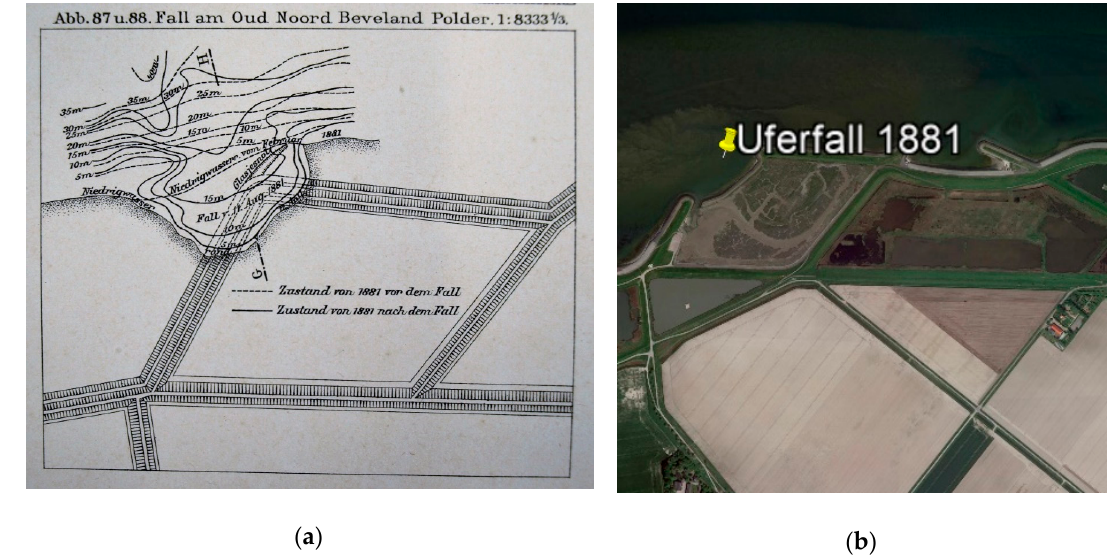
Figure 7. ( a ) Map of 1881 flow slide (Uferfall) at Oud Noord-Beveland Polder, Zeeland. Original figure of Müller, W. Ernst Verlag, Berlin, 1898 [14]. For cross section G-H, see Figure 6. ( b ) Present day image of 1881 flow slide site with remains of dikes and a salt marsh, now called the Oesterput. Photo Google Earth, 2018.